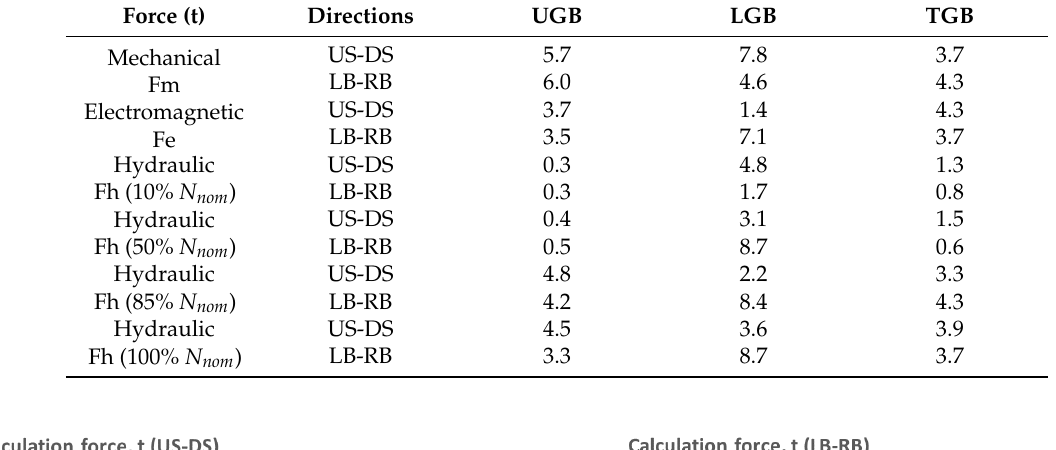
Table 4. Force applied to bearings.